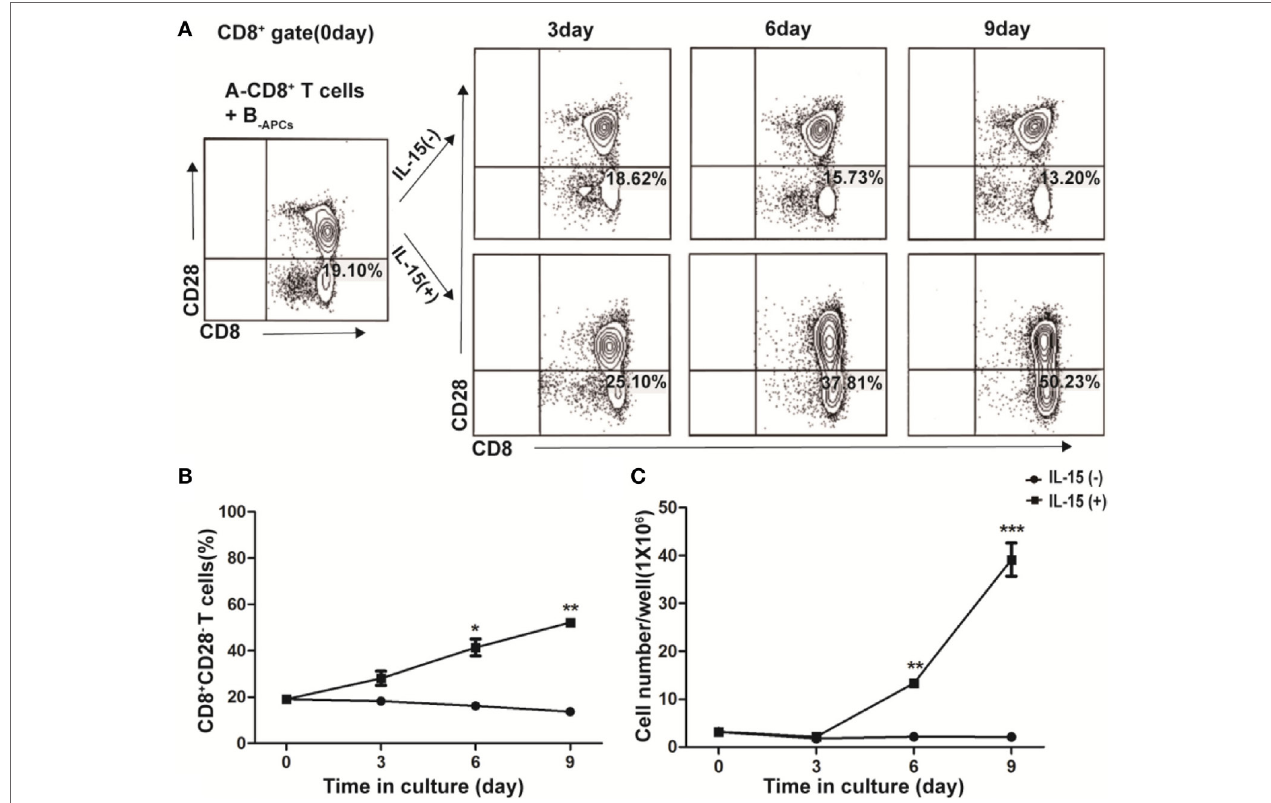
FigUre 1 | IL-15 promotes rapid expansion of CD8 + CD28 − T cells when cultured with allogeneic antigen-presenting cells (APCs) in vitro. CD8 + T cells isolated from healthy donor A were stimulated with human leukocyte antigen-A, -B, and -DR fully mismatched APCs from donor B (B- APC cells) in the presence or absence of IL-15 for 9 days in 24-well plates. (a) The fraction of CD28 − CD8 + T cells in CD8 + T cells were calculated after cultured for 0, 3, 6, and 9 days, respectively. (b) The dynamic average fraction of CD8 + CD28 − T cells in CD8 + T cells over time. (c) Cell number of each well after expansion over time in the presence or absence of IL-15. Data shown in (a) was representative of three independent experiments. Data shown in (b,c) were the average value of three independent experiments. * p < 0.05, ** p < 0.01, and *** p <